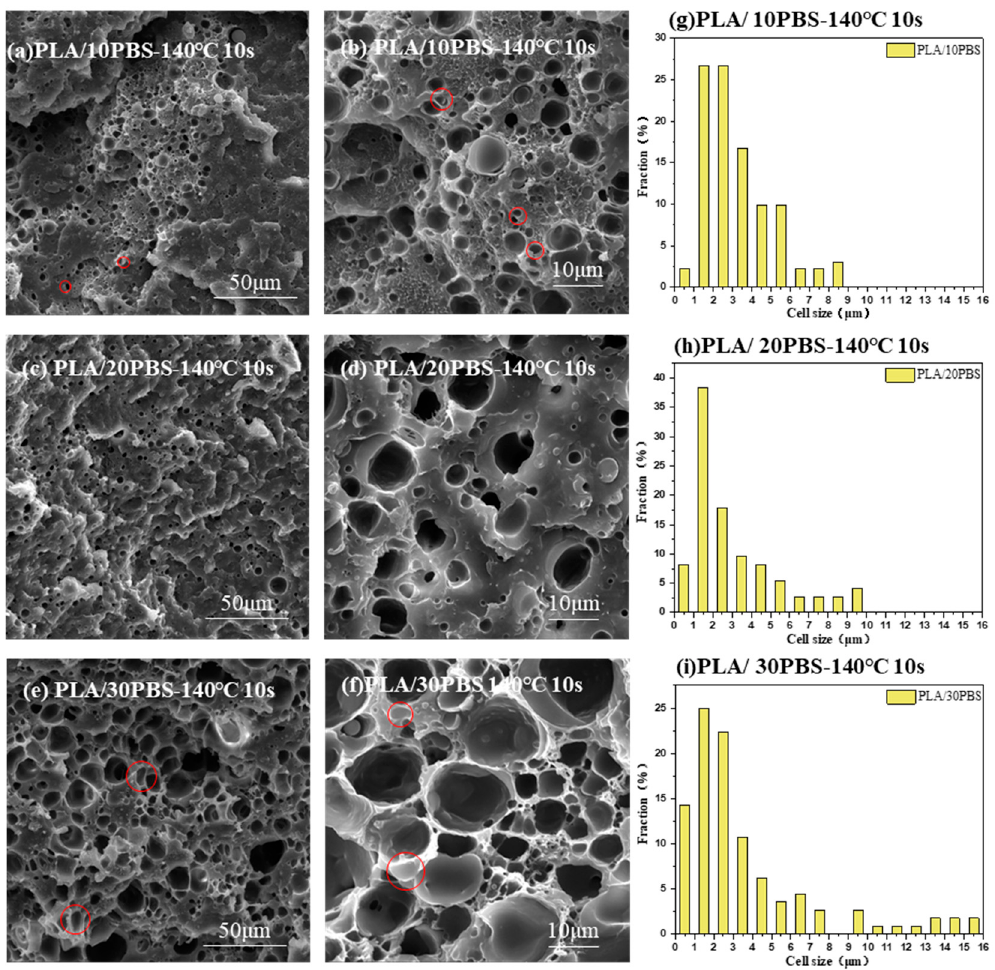
Figure 5. Scanning electron microscopy (SEM) images for PLA/PBS after foaming at 140 °C for 10 s. ( a ) PLA/10PBS 1000×; ( b ) PLA/10PBS 3000×; ( c ) PLA/20PBS 1000×; ( d ) PLA/20PBS 5000×; ( e ) PLA/30PBS 1000×; ( f ) PLA/30PBS 3000×; ( g ) cell size distribution of PLA/10PBS; ( h ) cell size distribution of PLA/20PBS; ( i ) cell size distribution of PLA/30PBS. (The red marks represent shaped